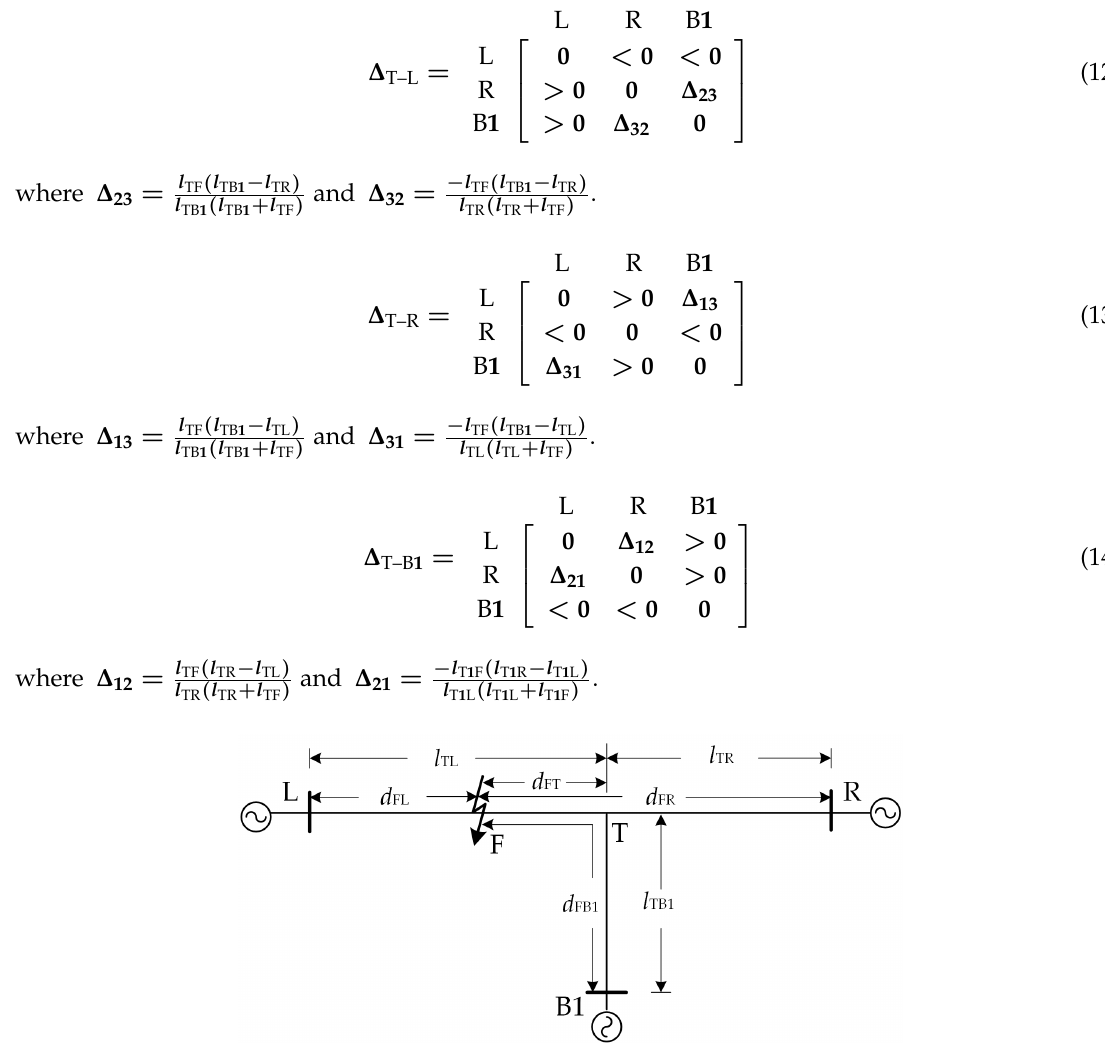
Figure 4. Three-terminal line topology.